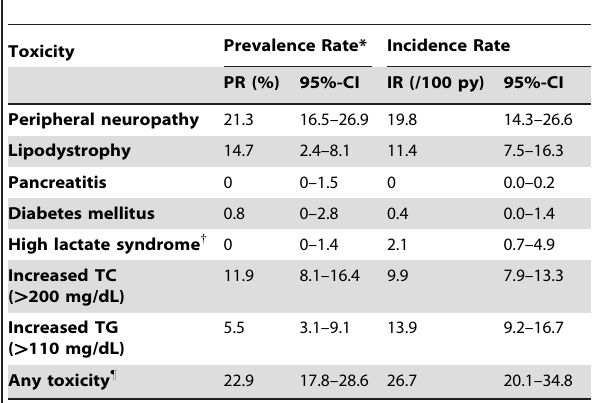
Table 2. Prevalence rates at enrolment and incidence rates during 12 months of follow up of stavudine associated toxicities in 253 Malawian